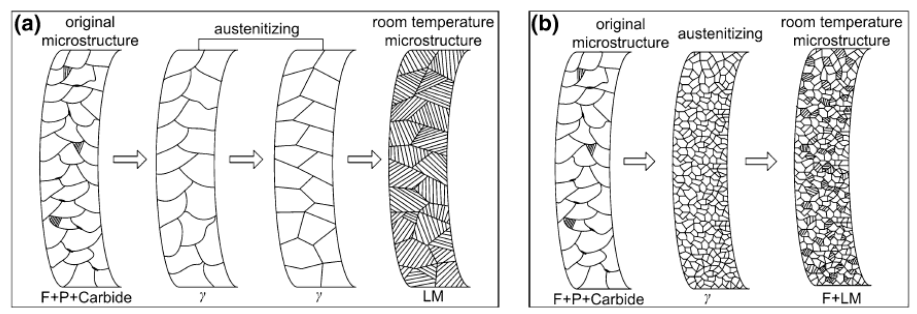
Figure 11. Schematic illustration showing microstructure evolution during laser welding ( a ) CGHAZ and ( b ) FGHAZ. Reprinted with permission from ref. [42]. Copyright 2014, Springer.